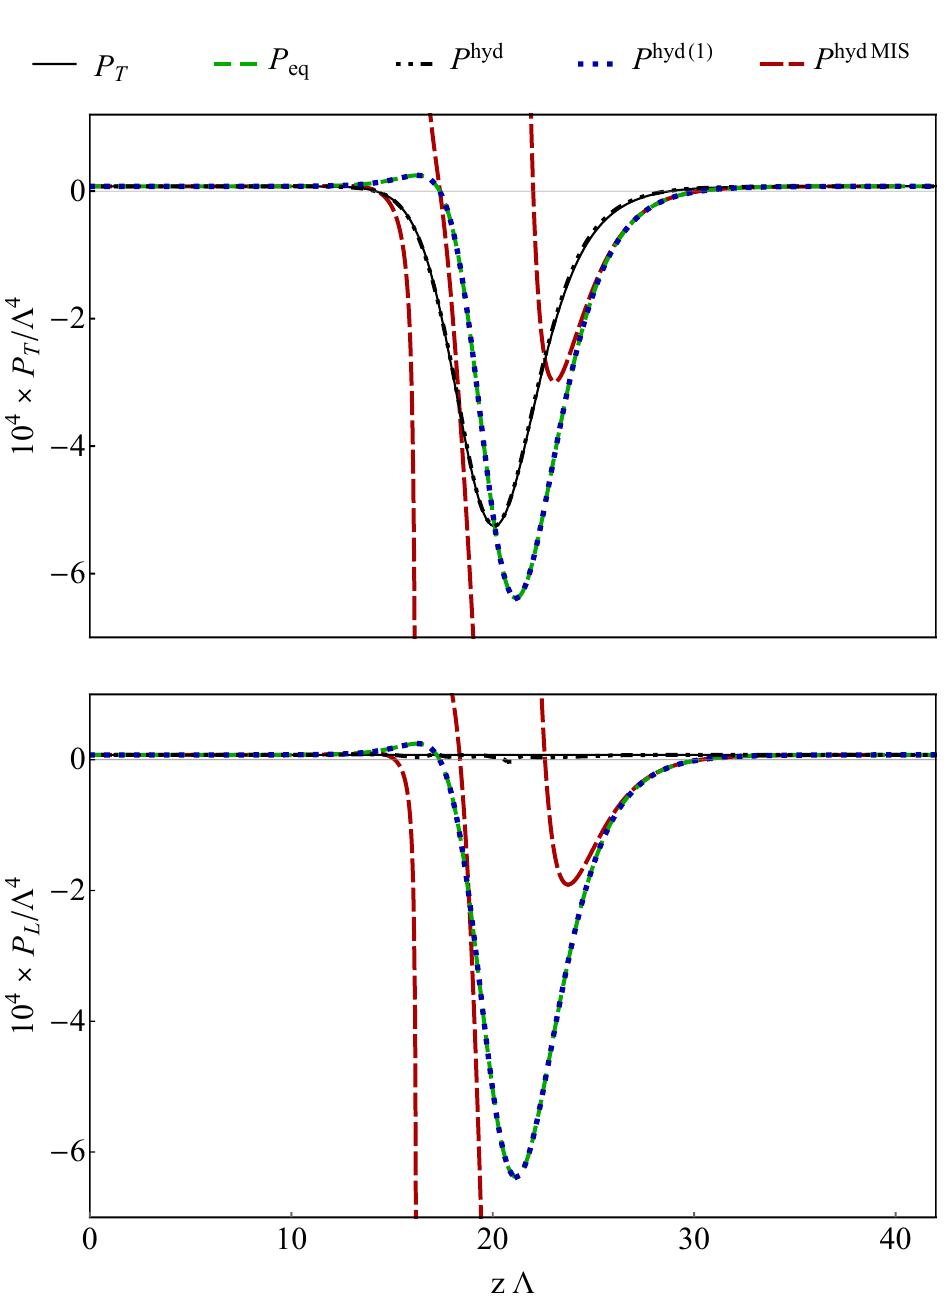
Figure 32 . Snapshots at asymptotically late times of the pressures for the evolution shown in (cid:12)gure 4(left). P L ; P T are the exact pressures extracted from gravity. The plot of P T is the same as in (cid:12)gure 29(bottom). P is the equilibrium pressure. P hyd(1) ; P hyd(1) are the hydrodynamic pressures eq L T with only (cid:12)rst-order viscous corrections included, i.e. those in T (cid:22)(cid:23) + (cid:5) (cid:22)(cid:23) . P hyd ; P hyd are the L T ideal (1) second-order hydrodynamic pressures in the purely spatial formulation omitting the contributions of ~ O (cid:22)(cid:23) and ~ S 4 . P hydMIS ; P hydMIS are the second-order hydrodynamic pressures in the MIS-type 7 L T formulation.